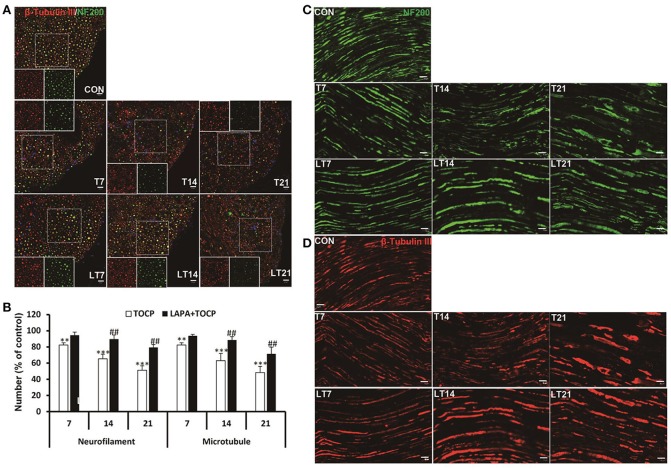
Alteration of axon numbers in spinal cord and sciatic nerve after various treatments by immunofluorescent staining of cytoskeletal proteins. (A) Immunofluorescent staining of spinal cord cross section for the neuron-specific microtubule protein (β-tubulin III, red) and neurofilament heavy chain (NF 200, green). Hoechst 33258 (blue) was used to stain nuclei. The single channel images of NF 200 and β-tubulin III from the region within the marked white square were shown in each treatment group. Scale bar: 20 and 5 μm outside and inside white square, respectively. (B) The numbers of axons expressing NF 200 and β-tubulin III, respectively, in anterior horn of lumbar spinal cord. The mean numbers of axons expressing NF 200 and β-tubulin III were 8,109 ± 254/mm2 and 8,926 ± 250/mm2 in control group, respectively (n = 3). (C,D) Immunofluorescent staining of β-tubulin III (red) and NF 200 (green) on longitudinal sections of sciatic nerve. Scale bar: 20 μm. CON, control; LAPA, lapatinib; T and LT plus number indicates the days after TOCP treatment and the treatment of lapatinib plus TOCP, respectively. **P < 0.01; ***P < 0.001 compared with the control group. ##P < 0.01 compared with the corresponding TOCP treatment group.